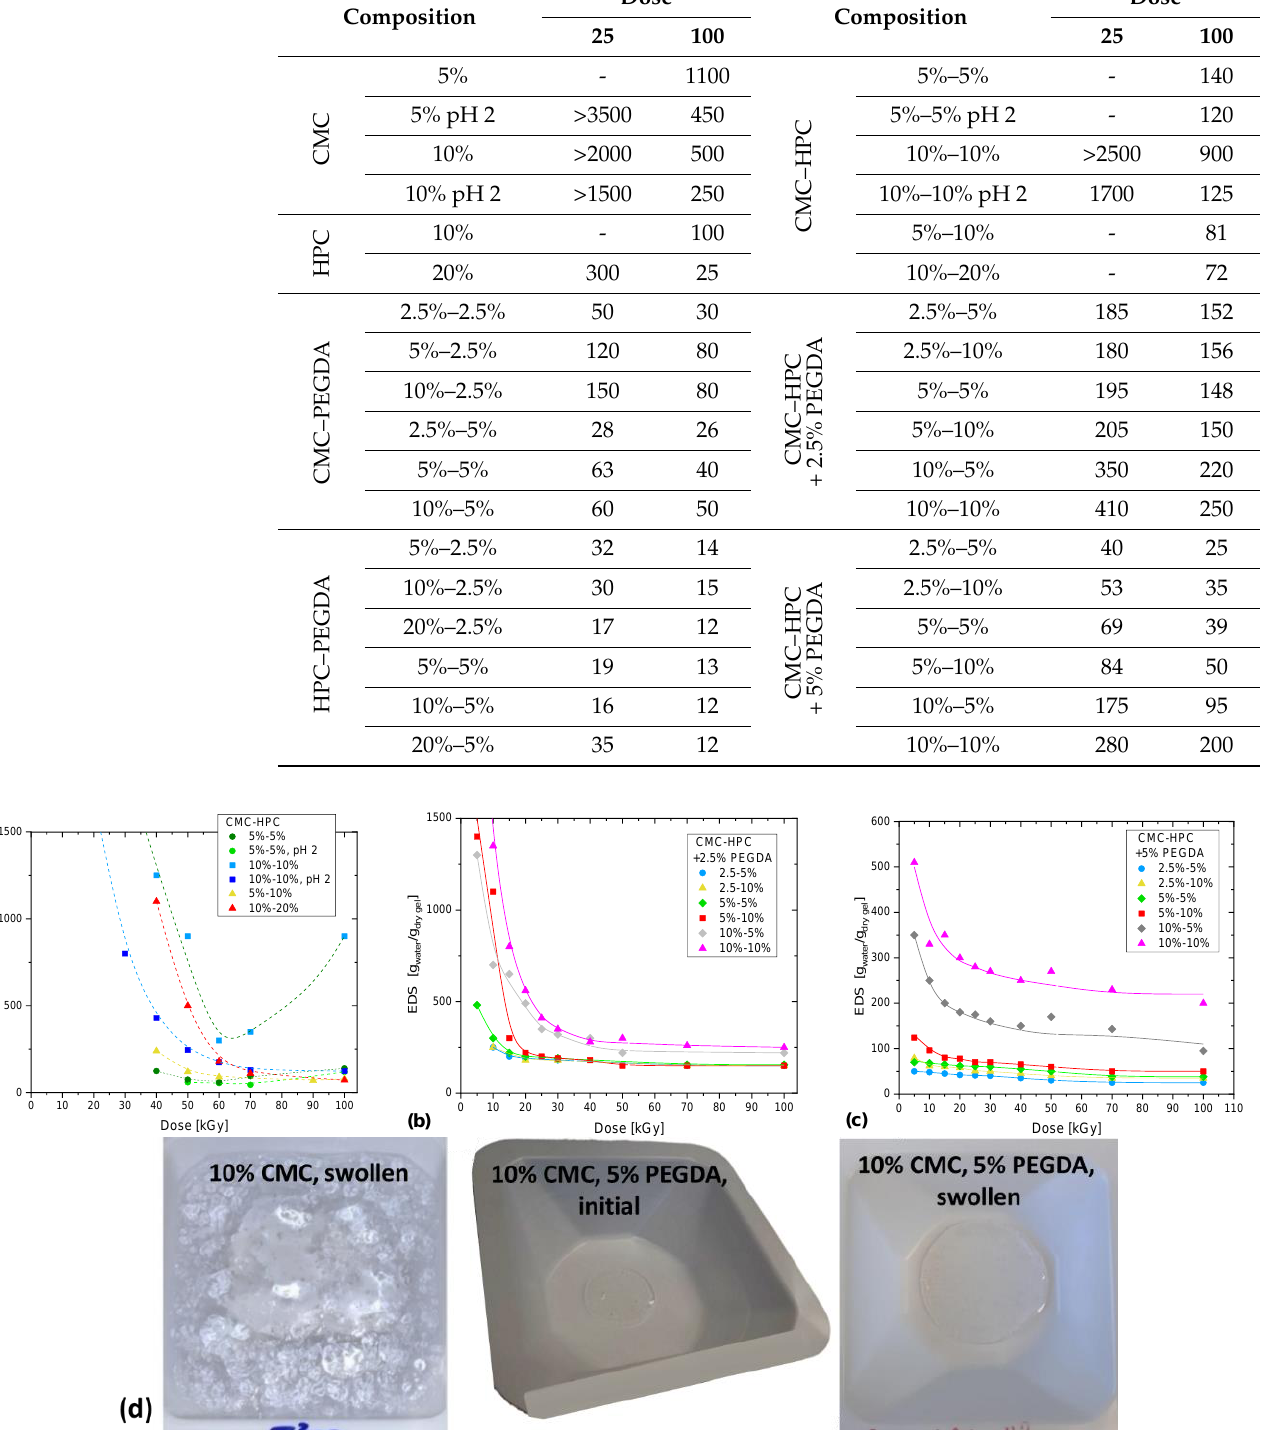
Table 1. EDS of hydrogels manufactured at two doses of 25 and 100 kGy (pH 2 denotes the acidic character of polymeric solution subjected to irradiation).